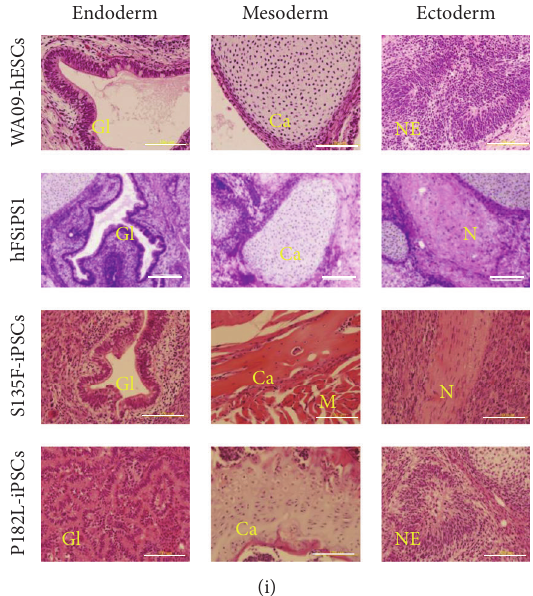
Figure 1: Generation of CMT2F patient and dHMN2B patient-derived iPSCs. (a) Experimental timeline for iPSC generation. KOSR, KnockOut (cid:2) serum replacement; bFGF, basic fibroblast growth factor. (b) Morphology of fibroblasts from normal individual and